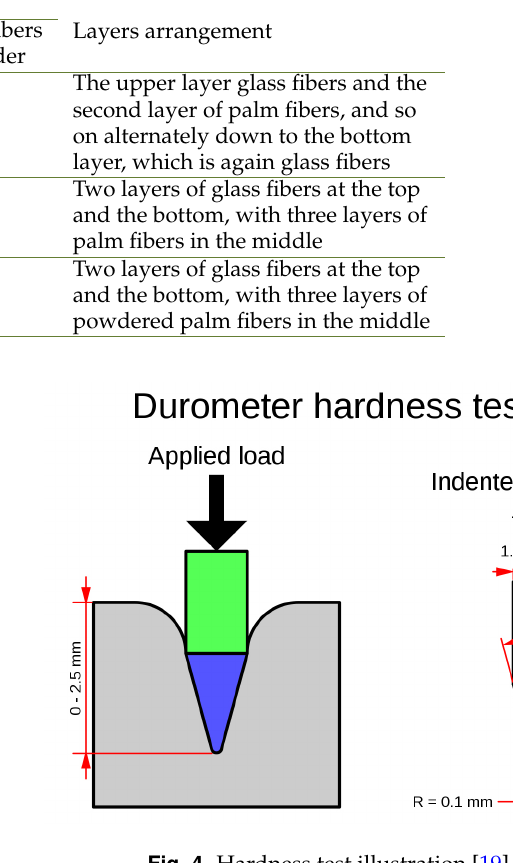
Fig. 4. Hardness test illustration